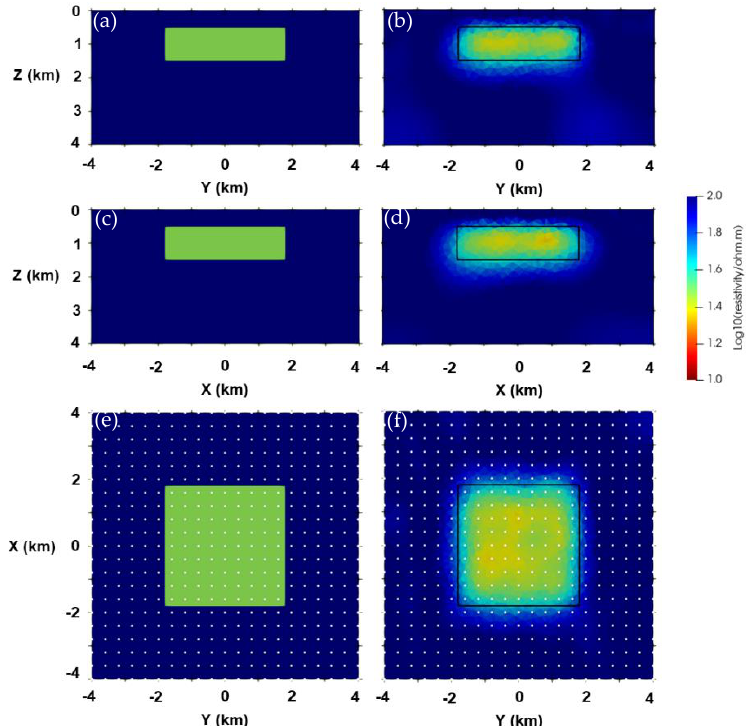
Figure 5. The inverted principal conductivity along the X-axis. Panels ( a ) and ( b ) show the true model and the recovered model at x = 0 km. Panels ( c ) and ( d ) show the true model and recovered model at y = 0 km. Panels ( e ) and ( f ) show the true model and the recovered model at z = 1 km.